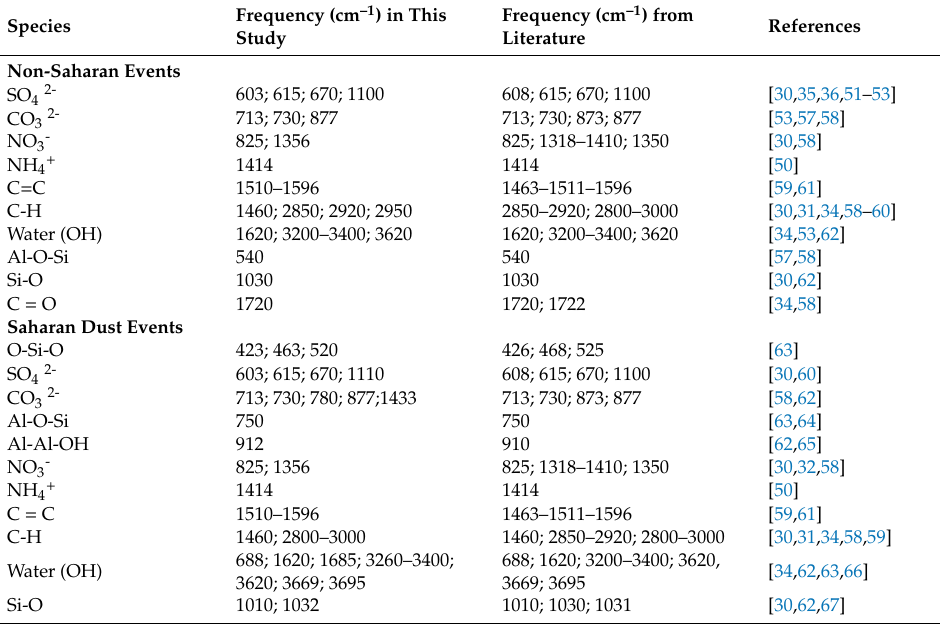
Table2. Typicalpeaksofinorganicandorganicmoleculesidentifiedinfiltersamplesduringnon-Saharan events and Saharan dust